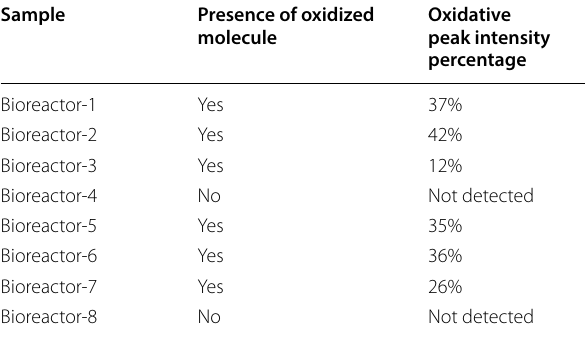
Table 2 ESI–mass spectrometry study results Sample